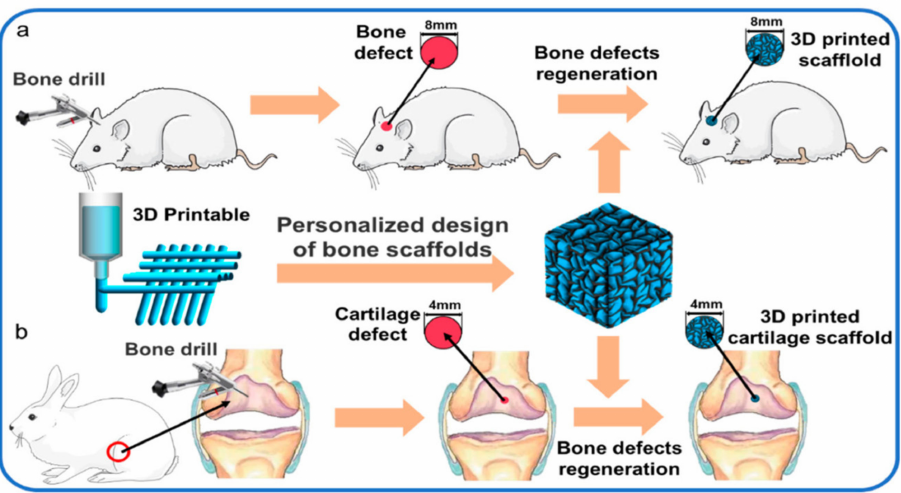
Figure 4. Printed bone scaffolds can replace the bone and cartilage defects in rat and rabbit, ( a ) regeneration of skull defect in rats; ( b ) articular cartilage regeneration in rabbits. Reproduced from [54] which is licensed under a Creative Commons Attribution-(CC BY 4.0) International License (http://creativecommons.org/licenses/by/4.0/, accessed on 17 April